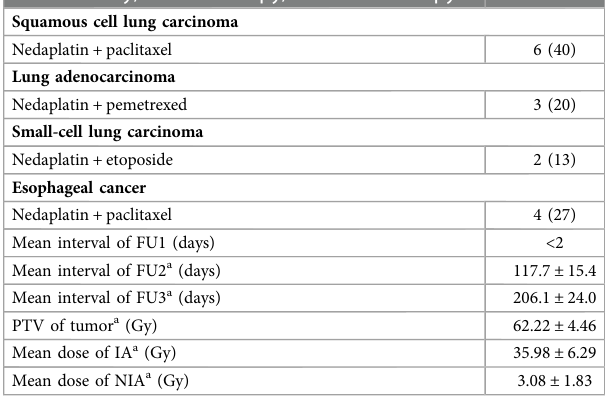
TABLE 2 Tumor entity and characteristics of cancer therapy within the study sample. Tumor entity, chemotherapy, and